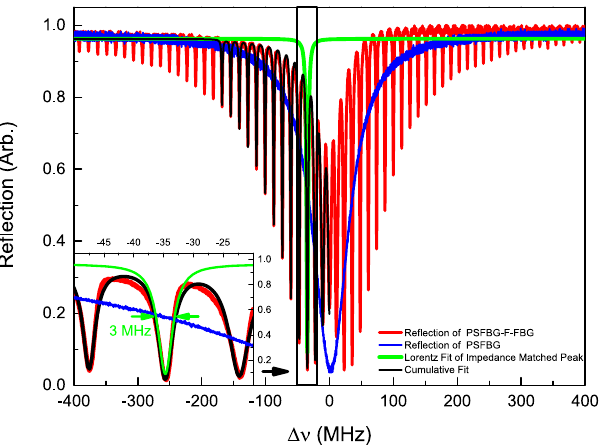
Figure 7. Experimental spectrum reflection of 7.3 m long PSFBG-F-FBG resonator, plotted versus the frequency detuning Δ v = C / λ − C / λ B . The red line is the reflection spectrum of PSFBG-F-FBG resonator, the blue line is the reflection spectrum of single PSFBG, the green line is the Lorentz fit of impedance matched resonant peak, and the black line is the cumulative fit of experiment data. Inset: Detail description of reflection spectrum of PSFBG-F-FBG resonator at the impedance matching peak.